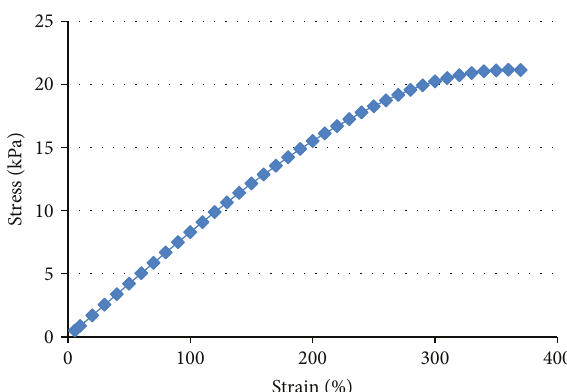
Figure 6: Uniaxial tensile test.